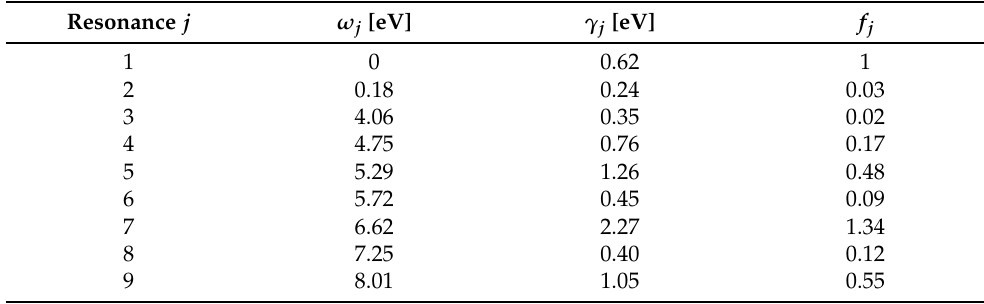
Table 3. The optical parameters of Drude–Lorentz model for ZrN obtained from DFT-GGA calcula- tions